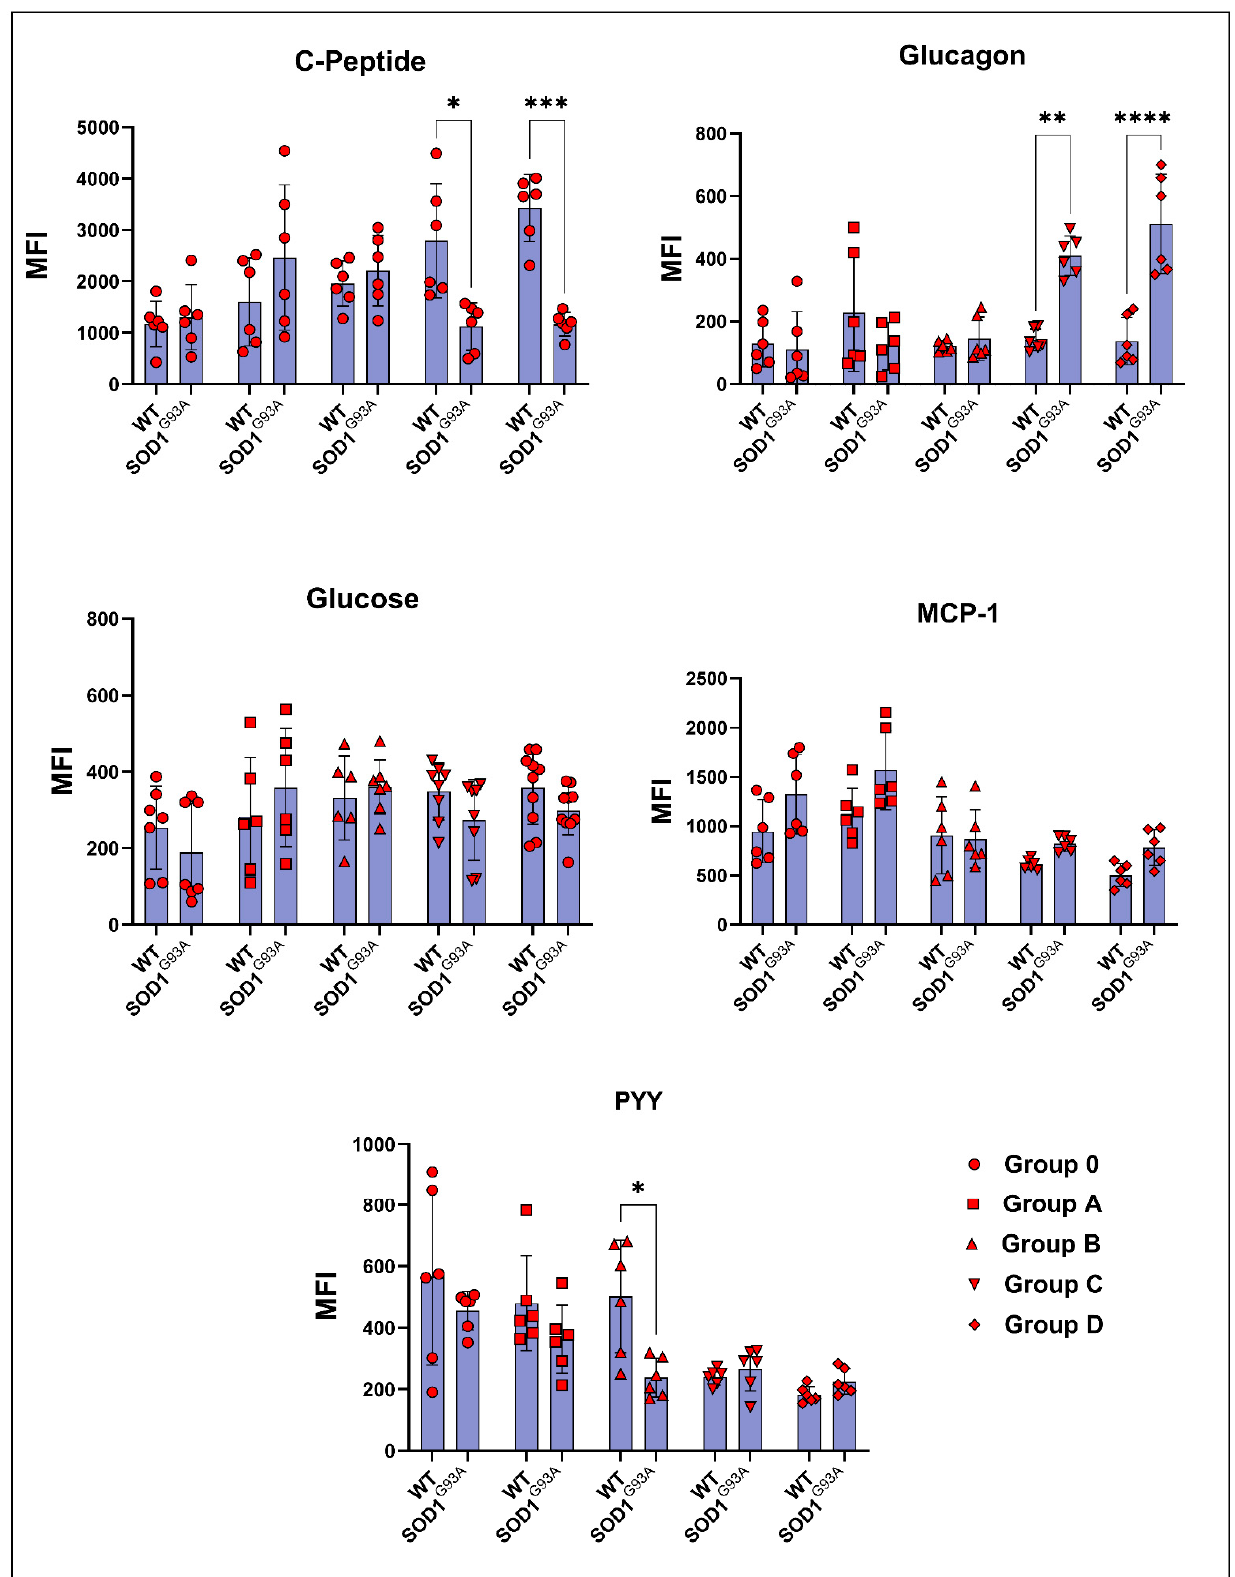
Figure 3. Serum hormone parameters of the SOD1 G93A and SOD1 WT rats. All results were given as mean ± SD of n = 6–8 animals for each group. Notes: * p ≤ 0.05, ** p ≤ 0.01, *** p ≤ 0.001, and **** p ≤ 0.0001.